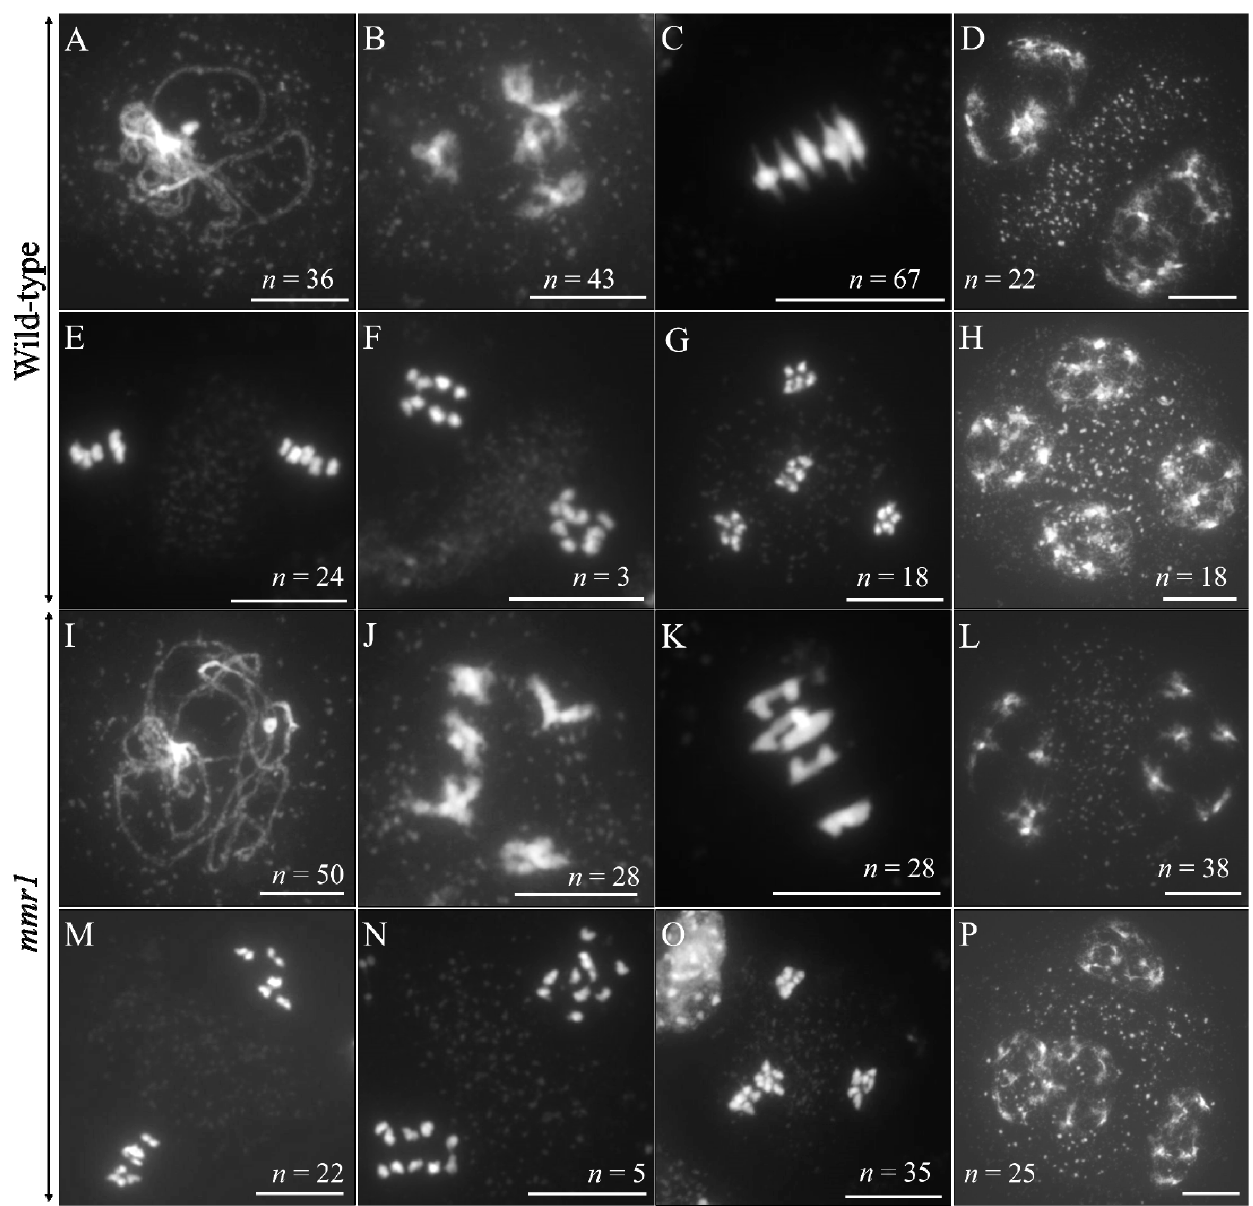
Figure 3. Meiotic spreading of wild-type Col-0 and mmr1 plants. ( A – H ) DAPI-stained chromosomes at pachytene ( A ), diakinesis ( B ), metaphase I ( C ), interkinesis ( D ), metaphase II ( E ), anaphase II ( F ), telophase II ( G ), and tetrad stage ( H ) in Col-0. ( I – P ) DAPI-stained chromosomes at pachytene ( I ), diakinesis ( J ), metaphase I ( K ), interkinesis ( L ), metaphase II ( M ), anaphase II ( N ), telophase II ( O ), and tetrad stage ( P ) in mmr1 . n indicates the number of observed cells at corresponding stages. Scale bars = 10 µ